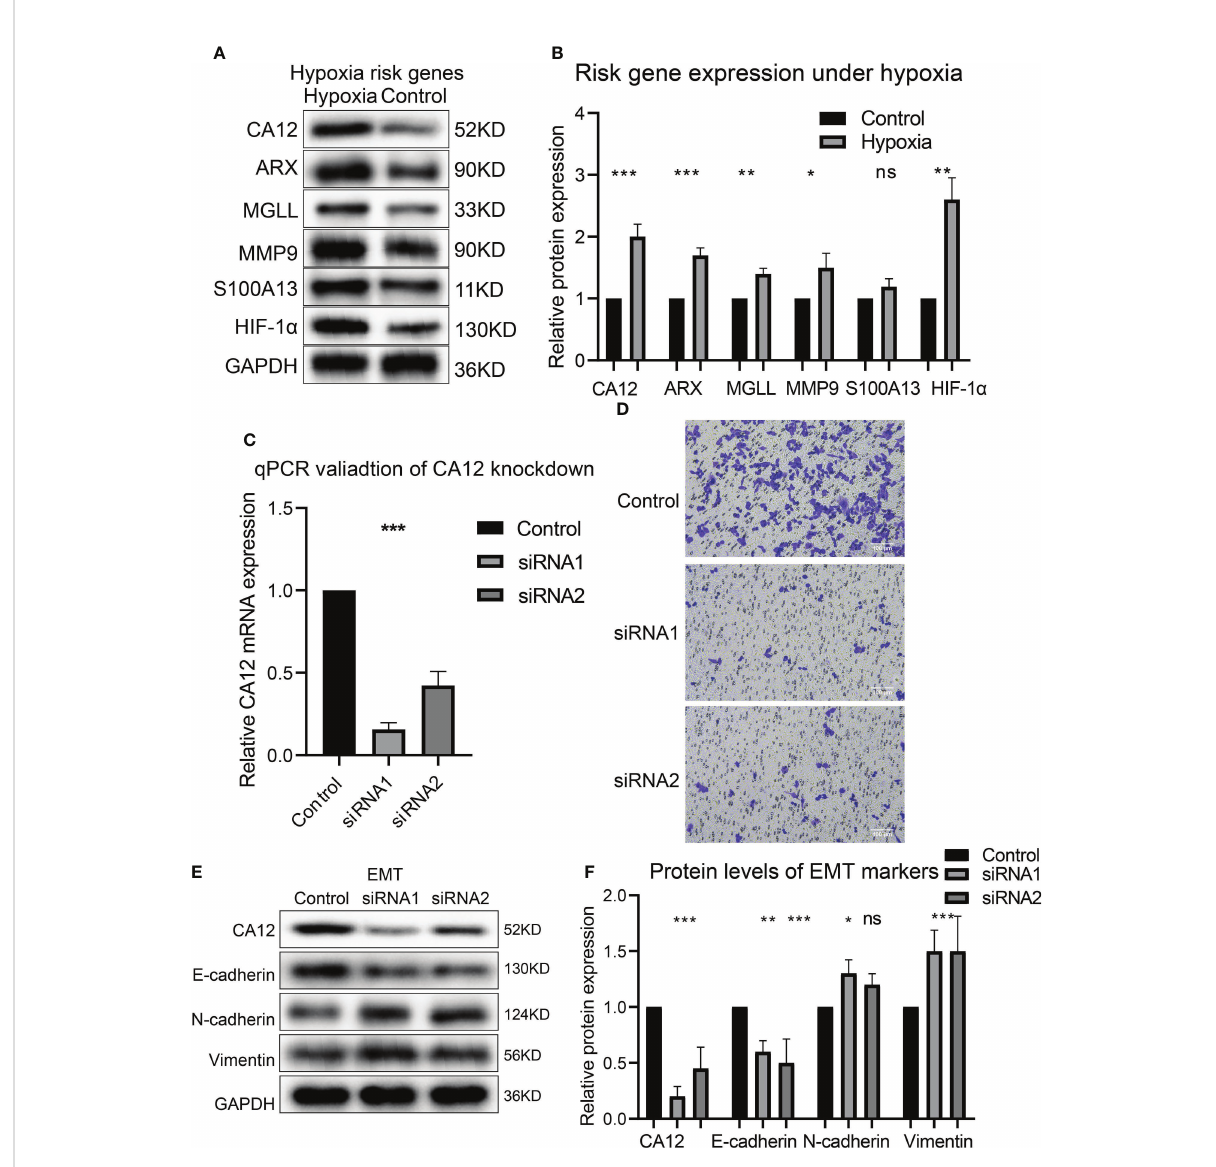
FIGURE 8 The risk gene expressions under hypoxia and the role of CA12 in UM cell EMT process. The protein bands of the risk gene expressions under normal and hypoxia conditions (A) and the quanti fi cation of the protein expression results in the box plot (B) . (C) The statistical comparison of the RT-qPCR results. (D) The image of transferred cells in control, CA12 knockdown-siRNA1, and siRNA2 groups. The bands of EMT pathway protein expressions (E) and their quanti fi cation in the box plots (F) between control, siRNA1, and siRNA2 groups, ns, *, **, *** represents not statistically signi fi cant, p-value < 0.05, 0.01, and 0.001,